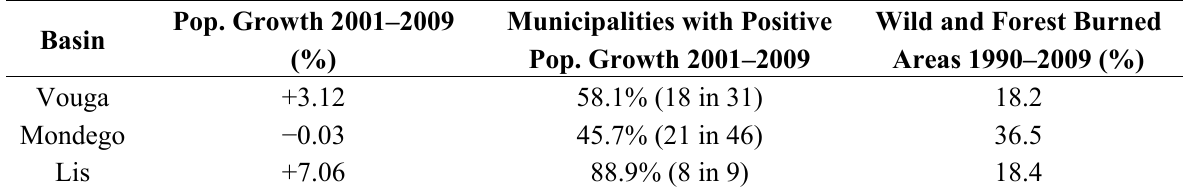
Table 1. Recent dynamics in the three selected